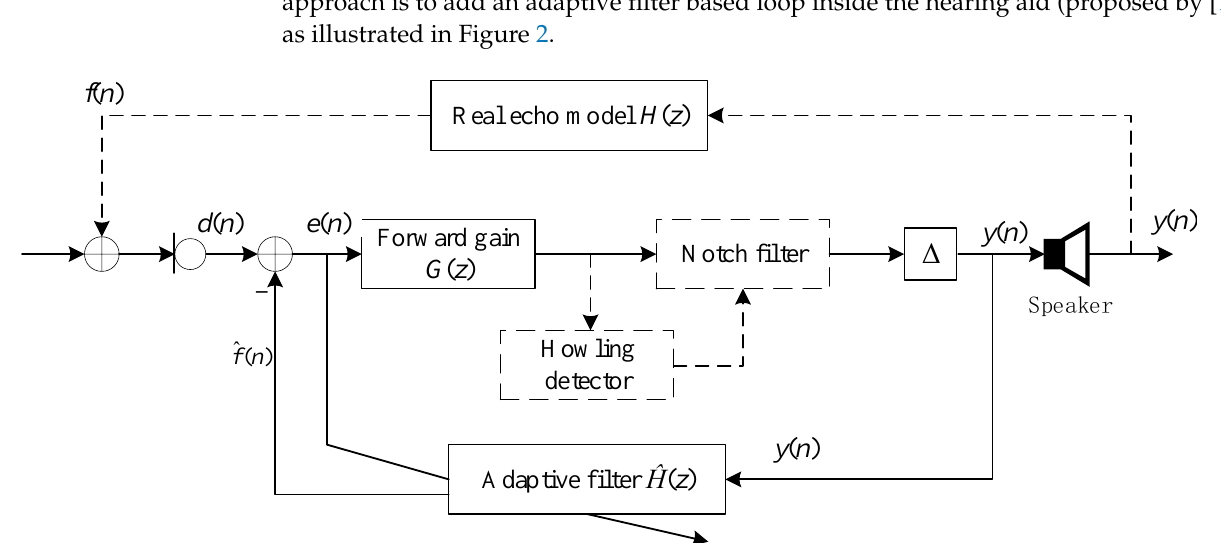
Figure 2. Echo cancellation algorithm model with adaptive filter for hearing